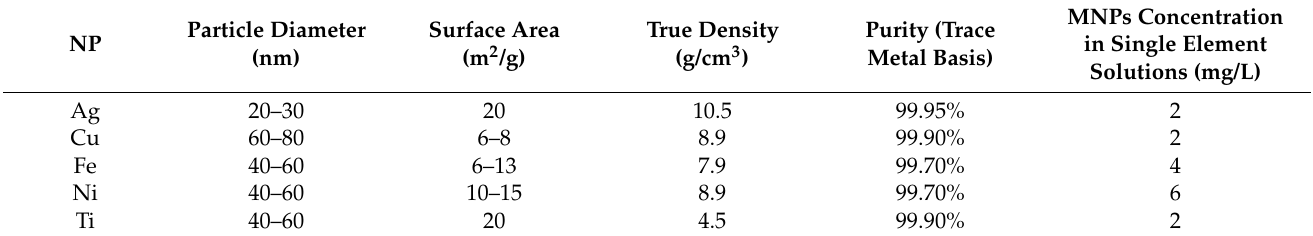
Table 1. Properties and dispersion sample concentrations of